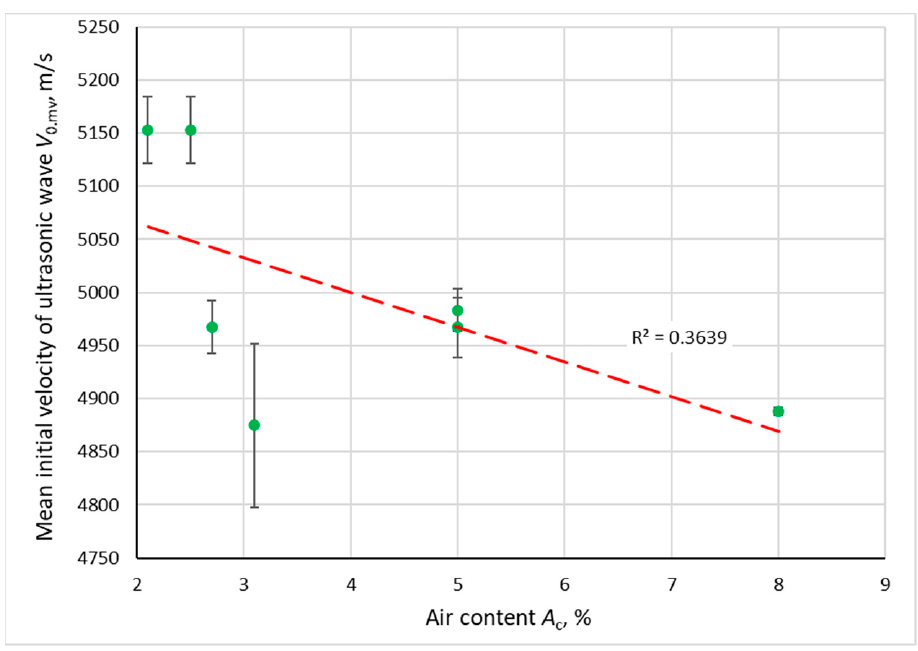
Figure 6. Dependence of the mean initial ultrasonic wave velocity (after 28 days of curing) on the air content in the concrete mix.